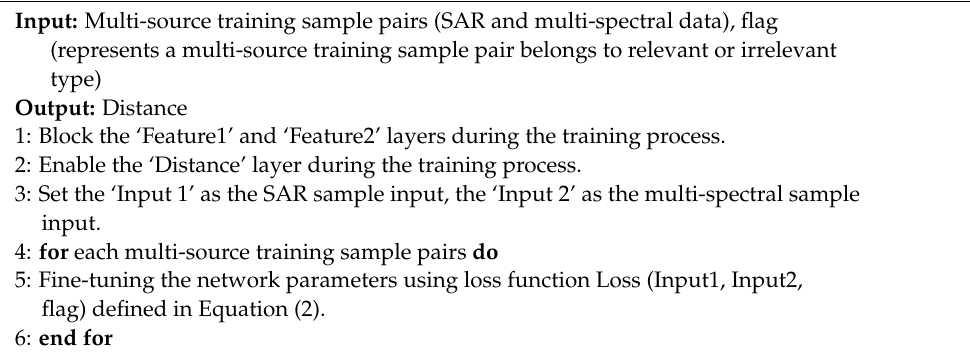
Algorithm 1. Training process of the common information extraction